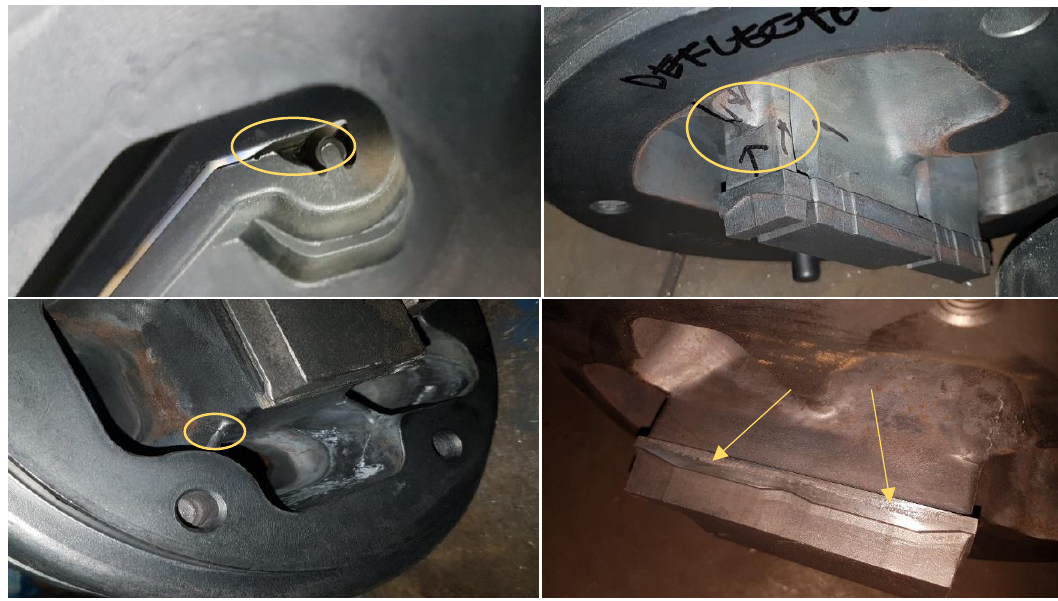
Figure 5. Some fracture and wear defects: bearing crack leading to fracture ( top left ); crack on rib and mandrel leading to deflection ( top right ); rib crack ( bottom left ); severe bearing washout ( bottom right ).